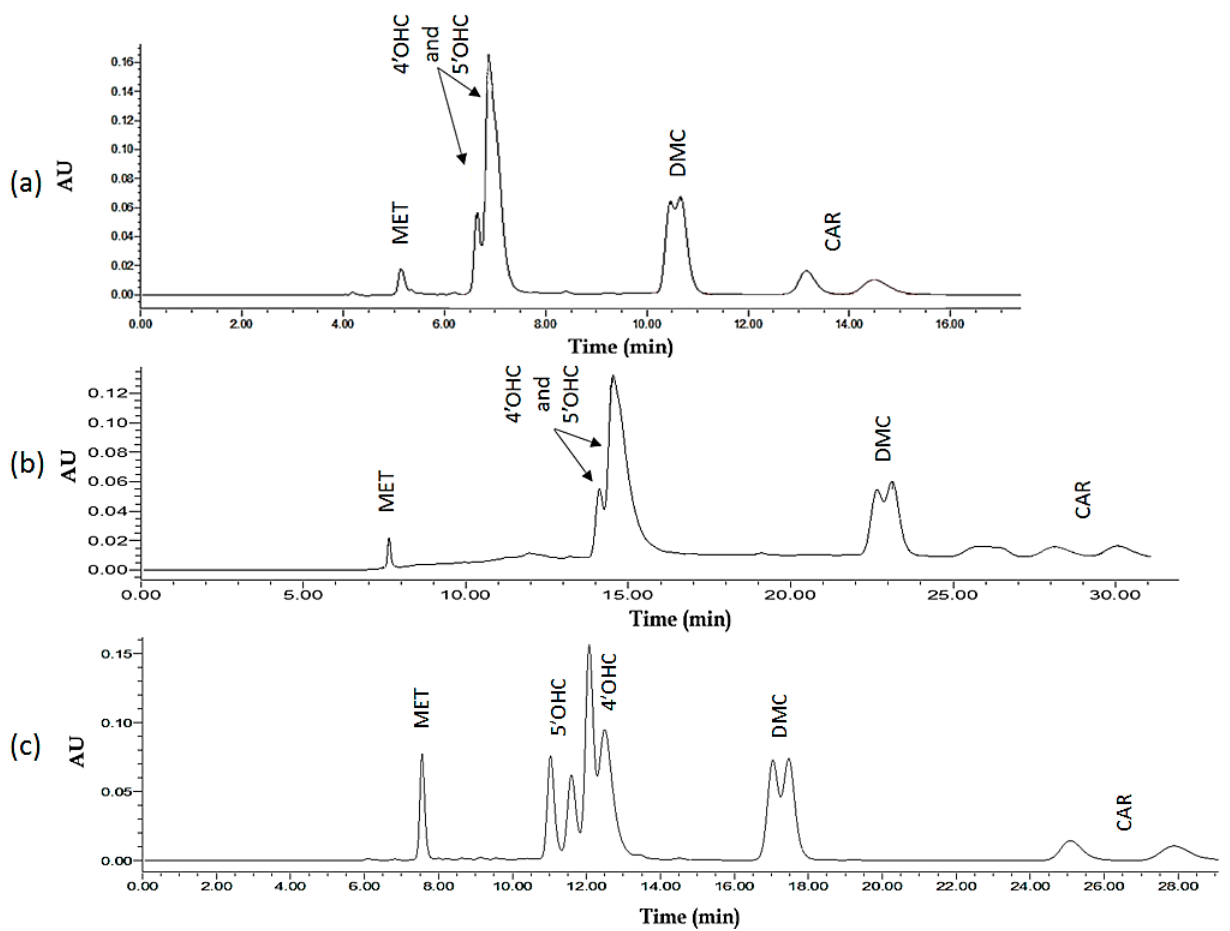
Figure 7. Chromatograms representing the chromatographic behaviour of the analytes and their resolution of the enantiomers of CAR and its major oxidative metabolites on Chiralpak IB N-5 as CSP using MET ( rac -metoprolol as IS) The injection volume is 10 μ L (of a 50 ng/mL solution of respective racemates): ( a ) An example for an unoptimized chromatogram. The mobile phase used consists of 80% organic modifier (50% acetonitrile: 50% methanol) and 20% 20mM potassium phosphate buffer pH 8, at a flow rate of 0.7 mL/min and 25 °C. ACN (60%), Peak assignments: MET (one peak); 5 ′ OHC and 4 ′ OHC (two peaks); DMC (two peaks); CAR (two peaks). ( b ) A second example for an unoptimized chromatogram. Here, mobile phase used consists of 60% organic modifier (100% acetonitrile) and 40% 20 mM ammonium acetate buffer pH 8, at a flow rate of 0.7 mL/min and 25 °C. ACN (60%), Peak assignments: MET (one peak); 5 ′ OHC and 4 ′ OHC (two peaks); DMC (two peaks); CAR (two peaks). ( c ) The ‘Global solution’ mobile phase used consists of 80% organic modifier (87% acetonitrile: 13% methanol) and 20% 20 mM phosphate buffer pH 7, at a flow rate of 0.5 mL/min and 25 °C. Peak assignments: MET (one peak); 5 ′ OHC (two peaks) ; 4 ′ OHC (two peaks); DMC (two peaks); CAR (two peaks).